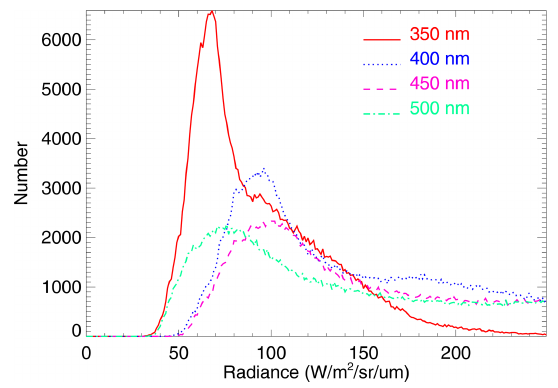
Figure A1. Histograms of radiance at different wavelengths from OMI row 1 (zero-based) data taken over a range of orbits as de- scribed